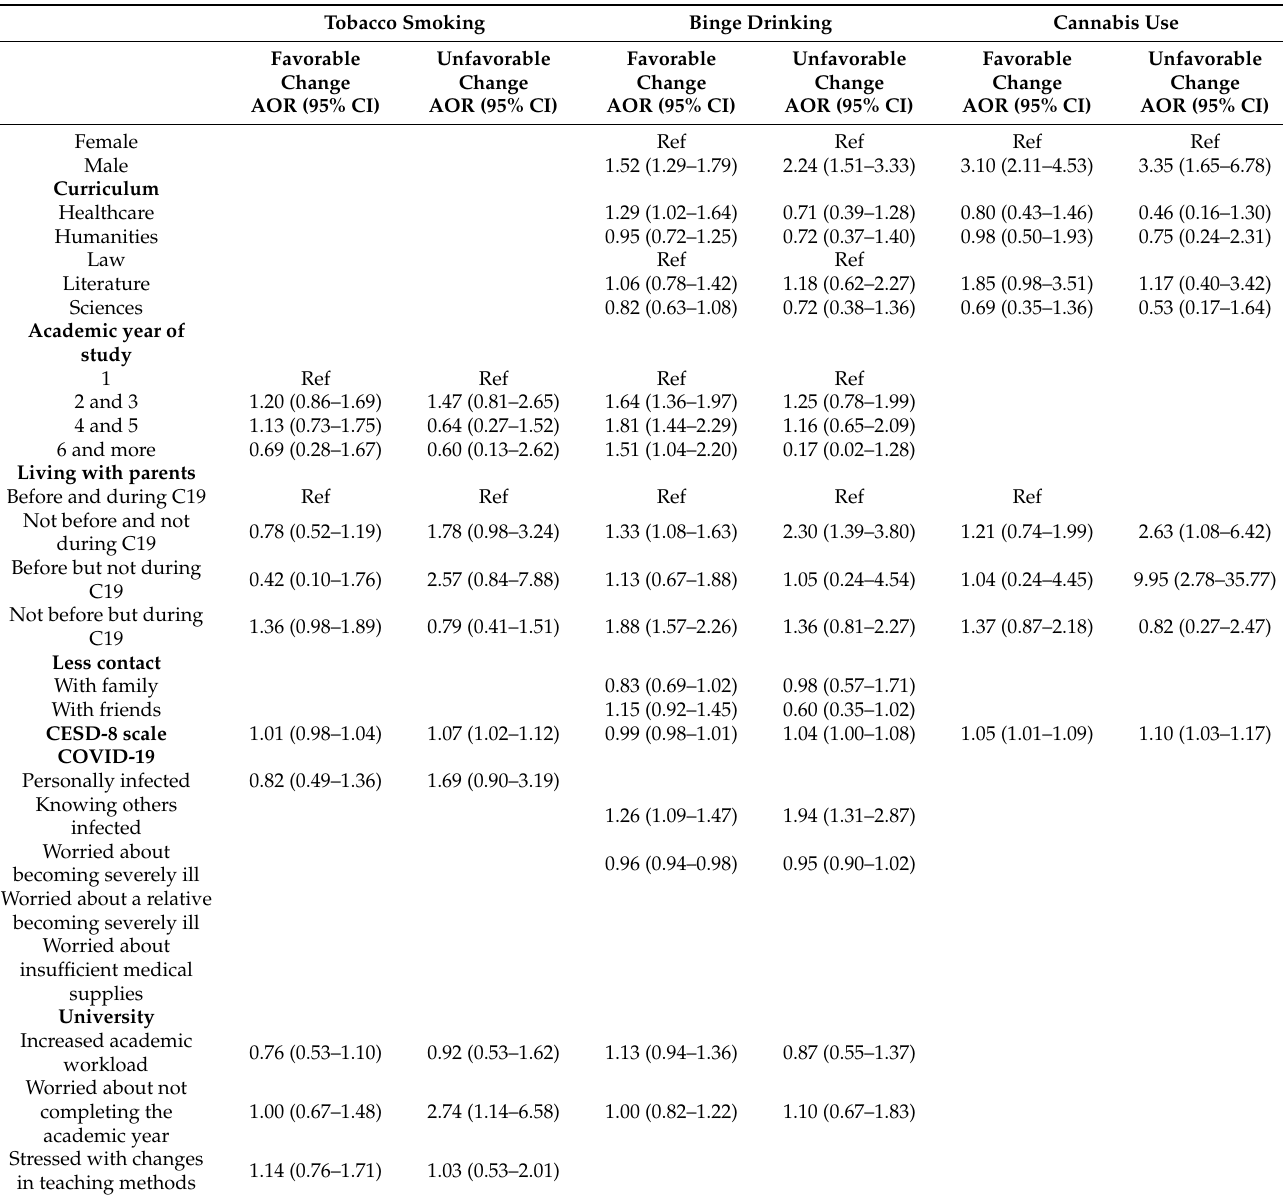
Table 2. Factors associated with favorable and unfavorable changes in tobacco smoking, binge drinking and cannabis use among university students during the COVID-19 lockdown ( n = 3671) (Logistic